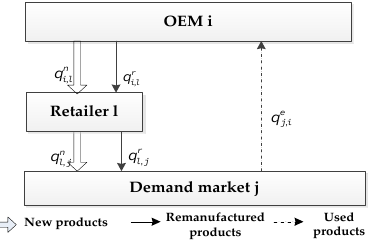
Figure 3. The transaction diagram of the IHRS model.